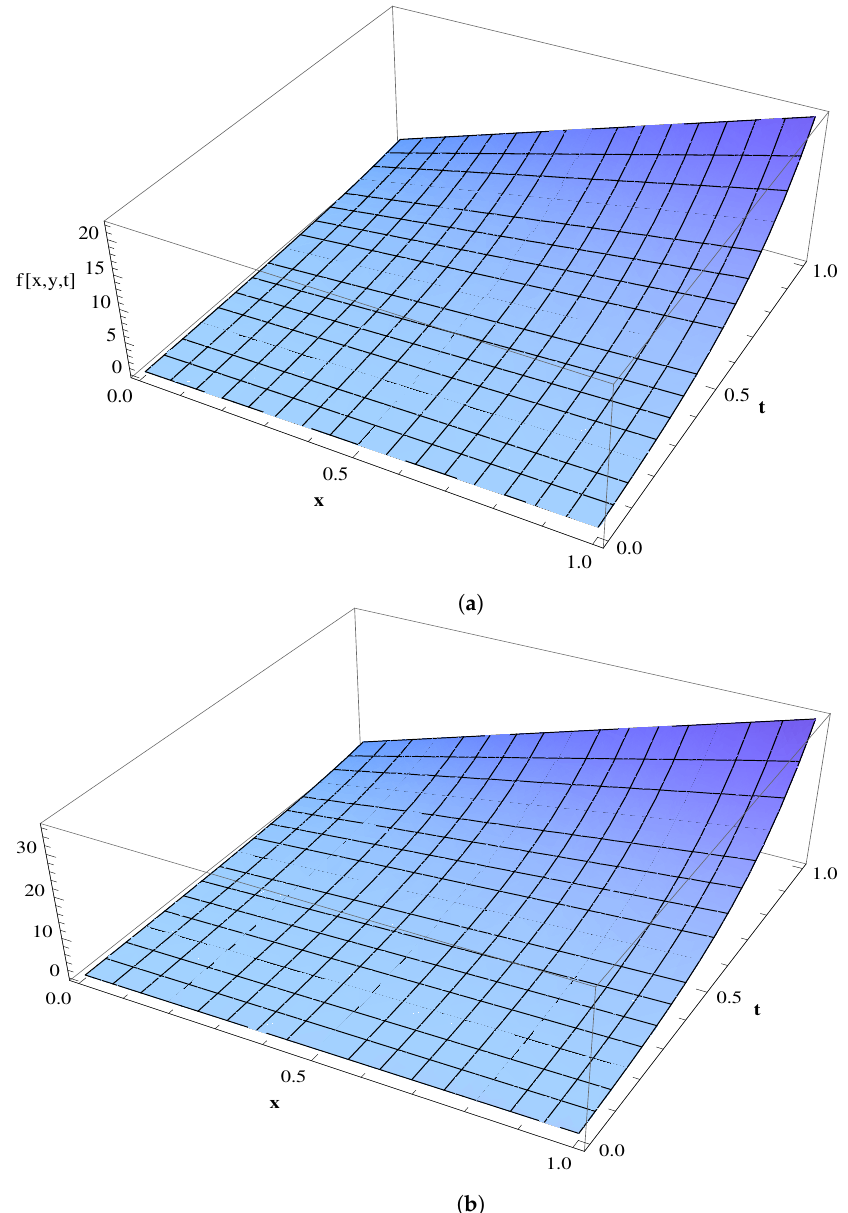
Figure 5. The FRDTM solutions f ( x , y , t ) : ( a ) (exact solution: nonfractional) β = 1 and ( b ) β =